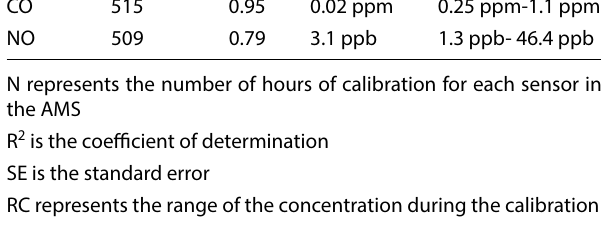
Table 2 Calibration 2 results of B4 gas sensors